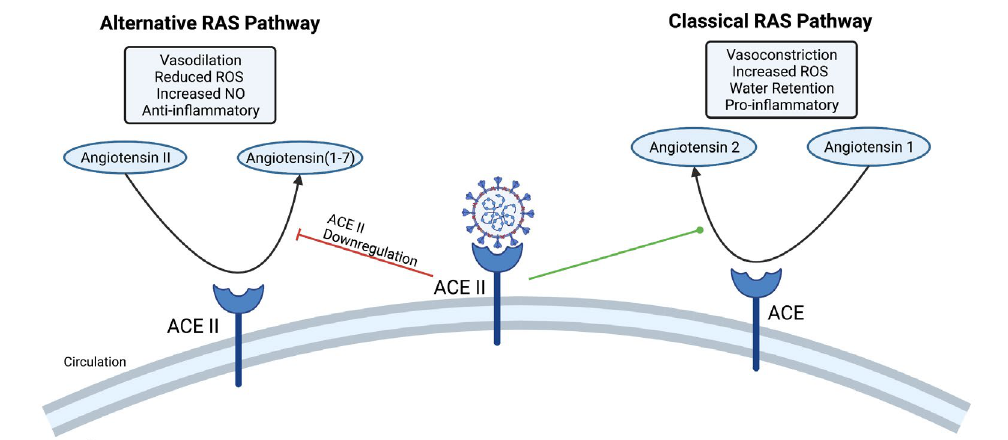
Figure 1. COVID-19 effect on the RAS pathway. The COVID-19 virus binds to the angiotensin-converting enzyme 2 (ACE2) receptor. This leads to a diminished alternative RAS pathway, which is known to have immunoregulatory effects including vasodilation, reduced reactive oxygen species (ROS), increased nitric oxide (NO) release, and anti-inflammatory effects. In turn, the classical RAS pathway dominates which leads to inflammation, vasoconstriction, increased ROS, and water retention. Created with